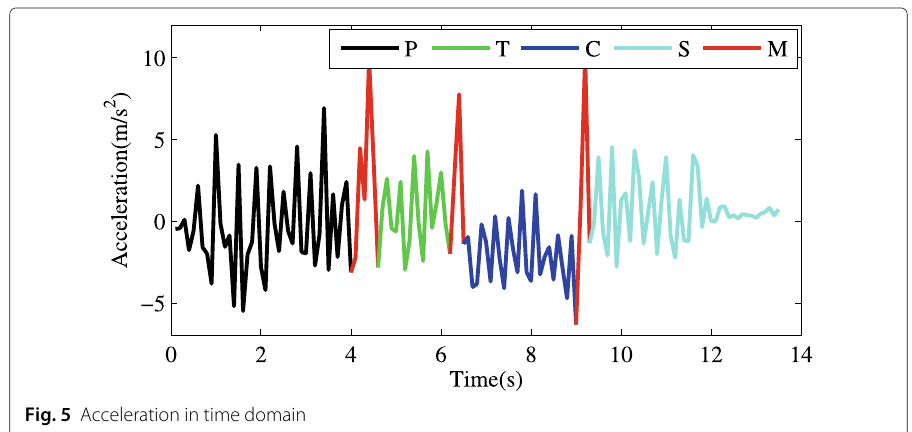
Fig. 5 Acceleration in time